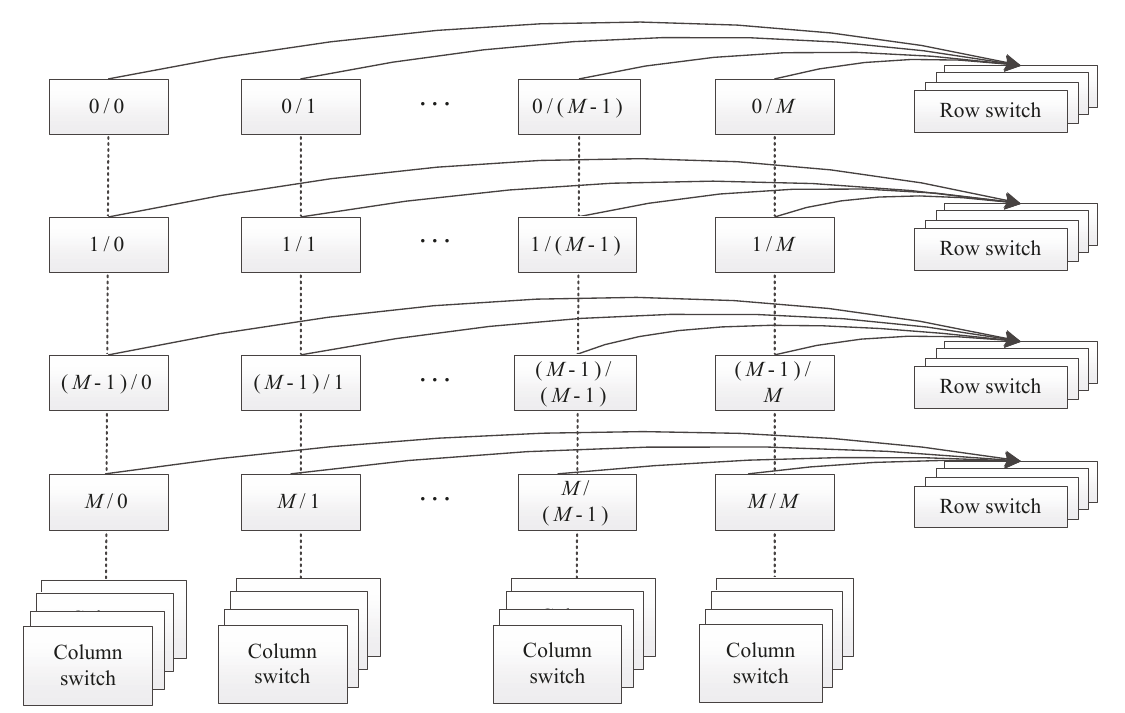
Figure 7. ICN topology of Tianhe exascale prototype system [12].